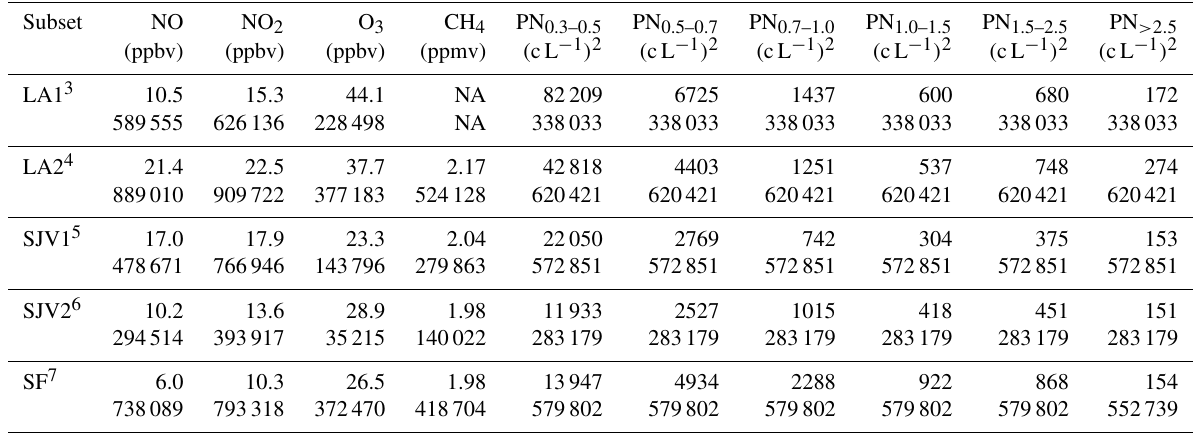
Table 7. Mean ambient concentrations and sample sizes as measured by the mobile platforms in each of the example study areas. 1 NA: not